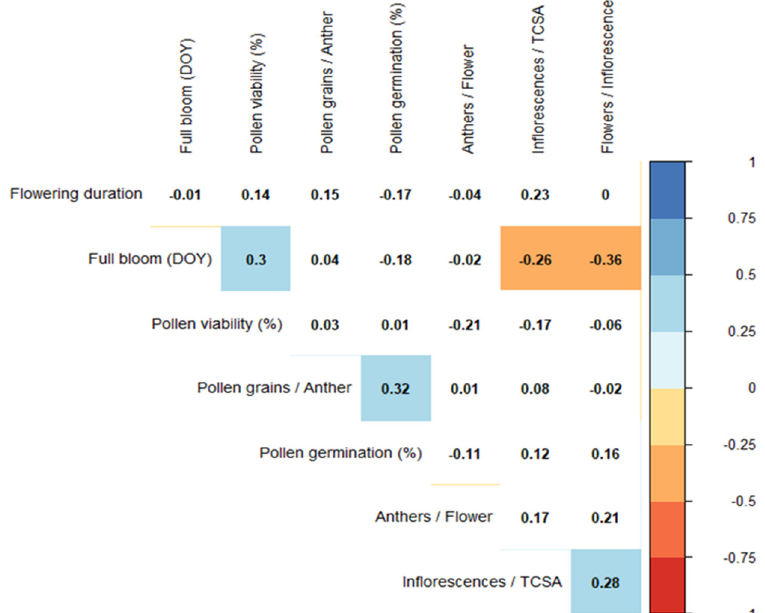
Figure 3. Pearson’s correlation coefficients between floral and pollen characteristics used to charac- terize 45 apple cultivars in Villaviciosa (north-western Spain). The color gradient shows the strength of the correlation. Correlations that were not significant at p < 0.05 are represented by white boxes.